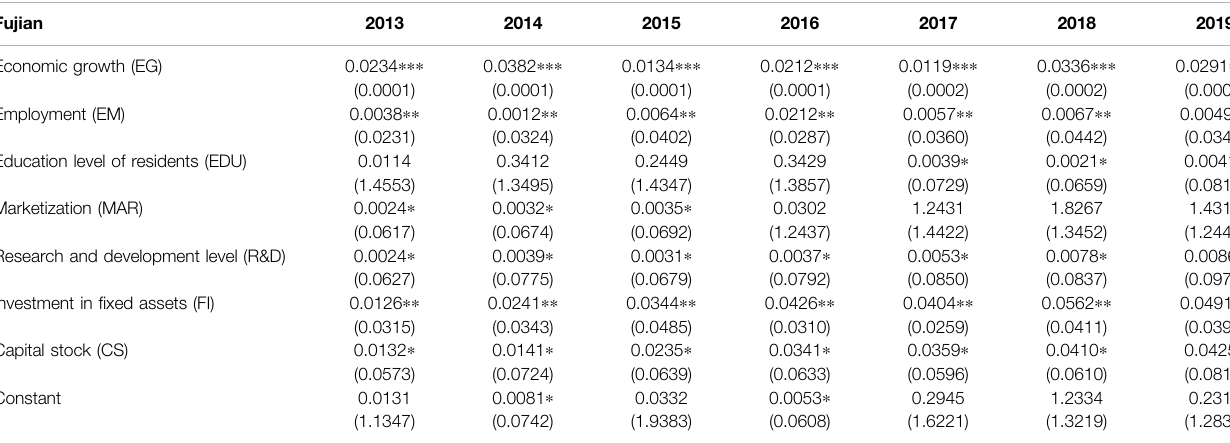
TABLE 6 | Driving force of Fujian health tourism industry convergence.